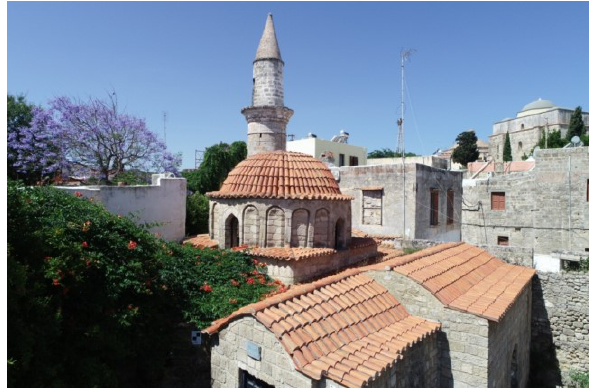
Figure 2. The church of St Spyridon today.